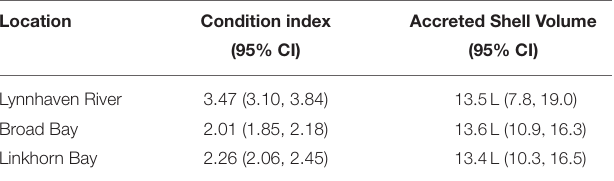
TABLE 5 | Condition index and accreted shell volume per m 2 on the constructed